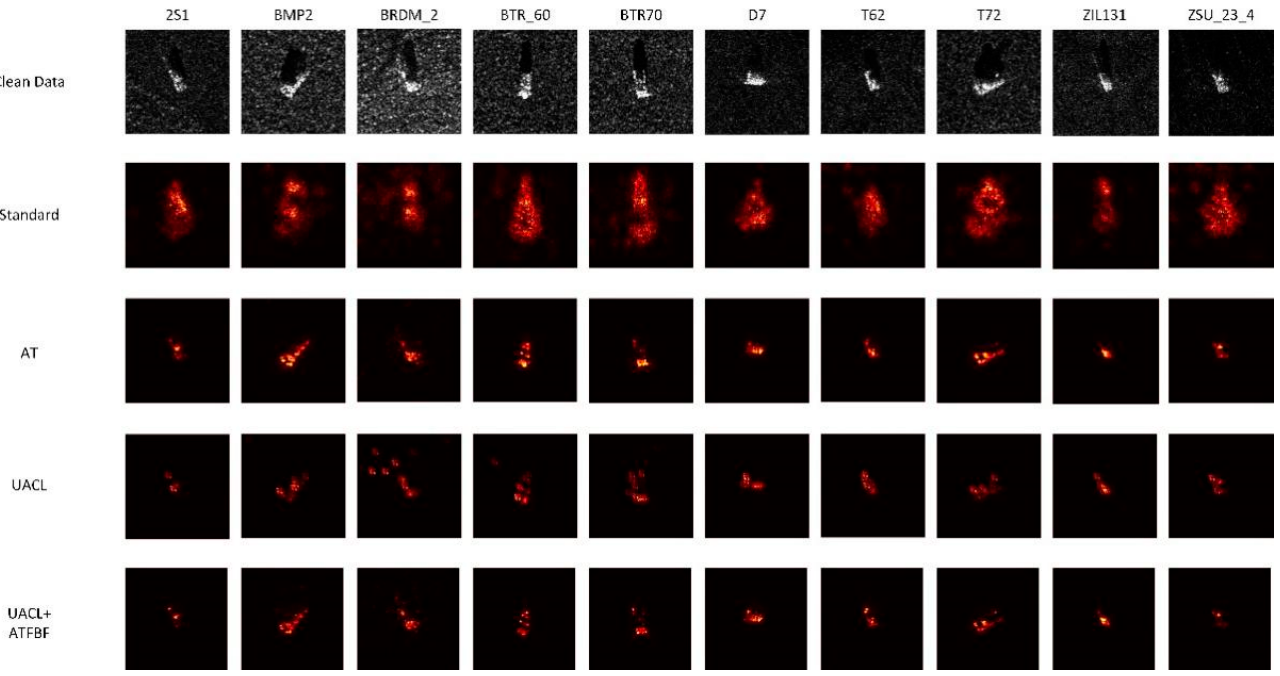
Figure 9. Guided backpropagation images of MSTAR model in the classification of clean data.